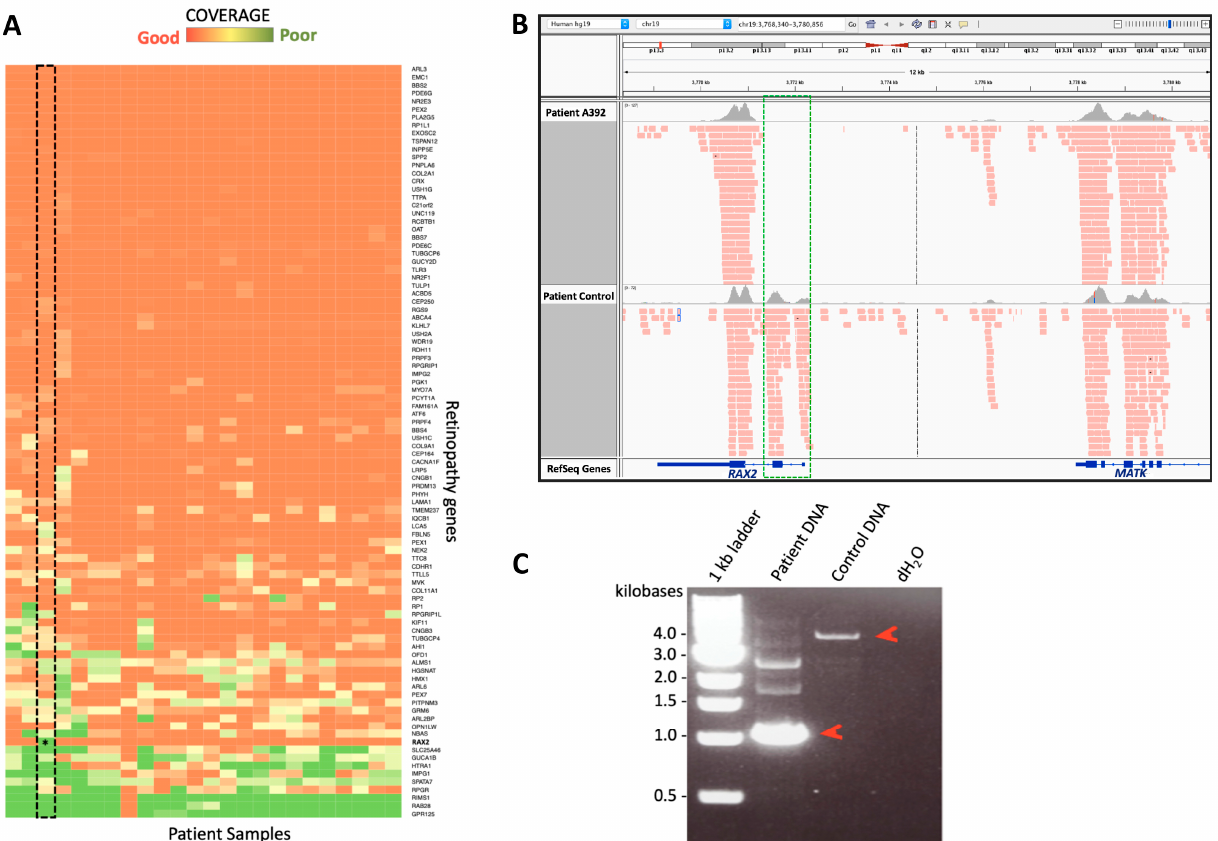
Figure 1. Experimental validation of the HD detected with our algorithm in the RAX2 gene. ( A ) Coverage heatmap of retinopathy genes in the WES data of IRD patients. Patient samples are shown in the x axis and gene names on the y axis. The extent of coverage is plotted according to the reported color scale. The RAX2 gene is well covered across all individuals but poorly covered in A392 (asterisk in the framed column). ( B ) IGV coverage tracks for the alignment file from patient A392 (upper track) and a control patient (lower track). The lack of reads spanning the exon 2 of RAX2 in A392 (green box) suggested that the corresponding region was deleted in both alleles of the analyzed proband. ( C ) PCR amplification of the genomic region spanning the identified deletion in the proband’s genomic DNA (‘Patient DNA’) and in a control DNA sample. The difference in size between the two amplicons (red arrowheads) indicates the presence of an extensive HD in the proband. Table 3. Availability of SNV/CNV analysis automation in existing open ‐ source software. Software SNV/Indel Calling CNV Calling